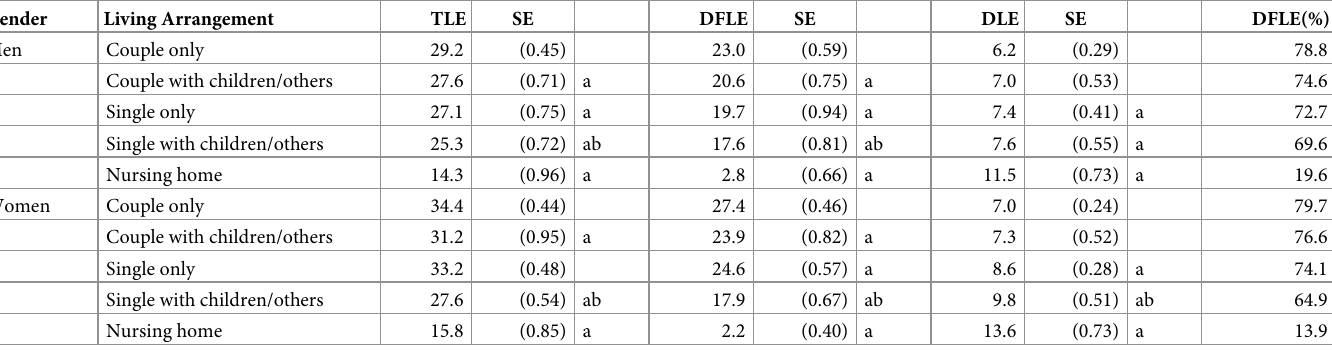
Table 6. Total, disability-free, and disabled life expectancy by gender and living arrangement for non-Hispanic whites at age 50: Population-based estimates: Sta- tus-based estimates with initial health state being disabled. Gender Living